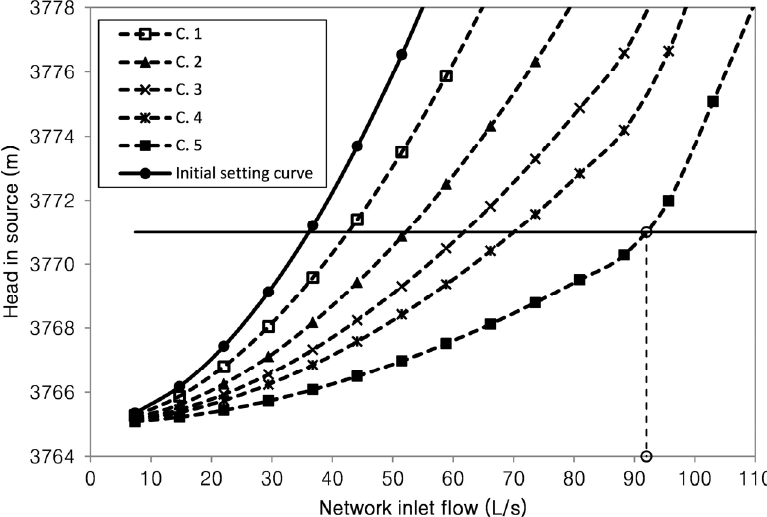
Figure 12. Setting curve evolution in the capacity increase process. Table 3. Results of the network capacity increase process.